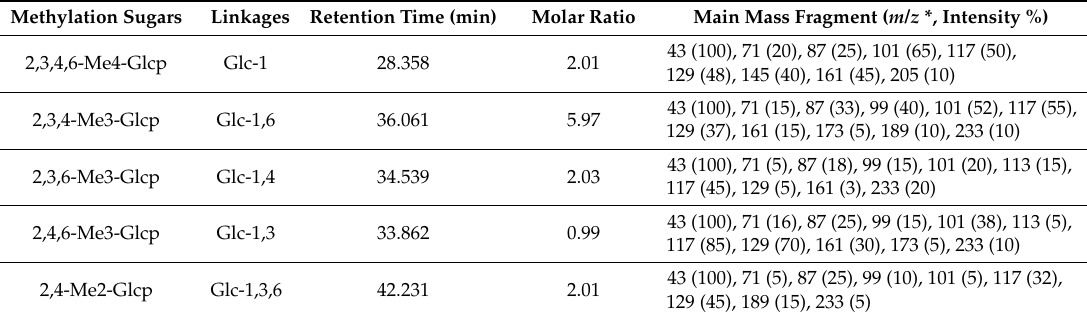
Table 1. Linkages and individual molar ratios of BP1 elucidated by methylation analysis.